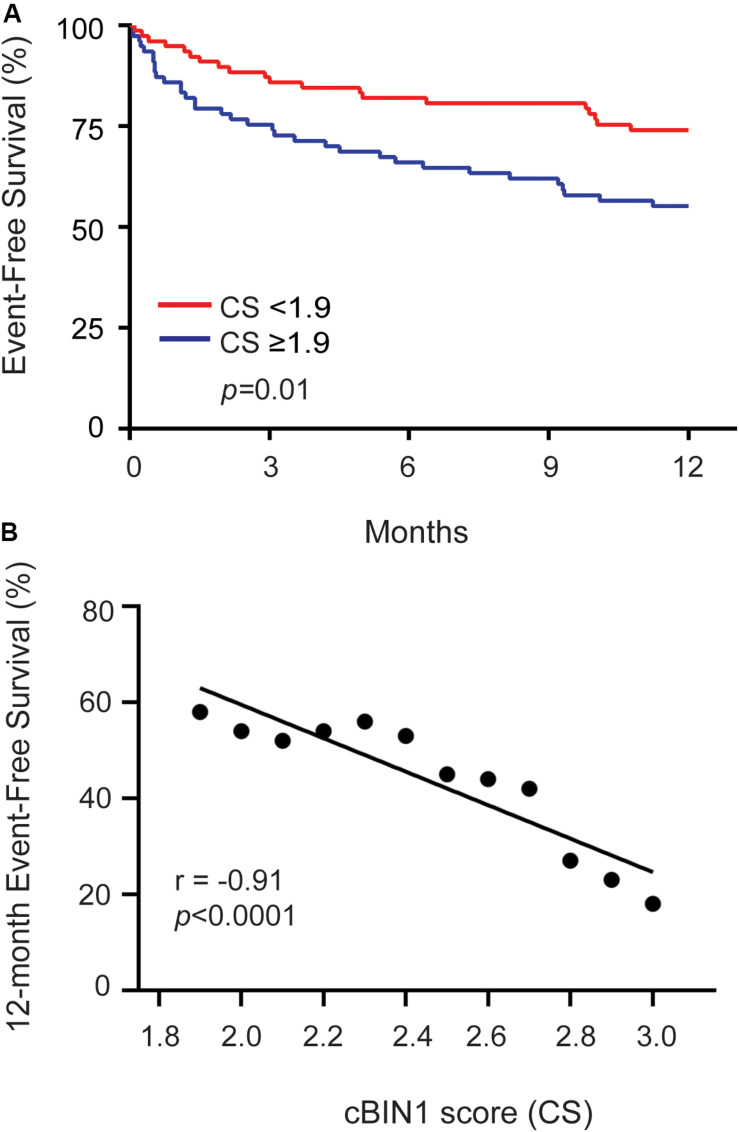
Cardiovascular event free survival of HFrEF patients during 12-month follow-up. (A) Kaplain-Meier survival curve is shown here for all HFrEF patients. The red line demonstrates patients with CS < 1.9 and the blue line demonstrate patients with CS ≥ 1.9. Event free survival is defined as patients who did not have a cardiovascular (CV) event (HF-related hospitalization, cardiac hospitalization, LVAD, OHT, or death) during 12-months follow-up. A low CS (<1.9) predicted a higher event-free survival among all HFrEF patients (p = 0.01). (B) Scatterplot of 12-month event-free survival vs. CS for all CS ≥ 1.9 indicates a negative correlation (Pearsons’s correlation coefficient −0.91, p < 0.0001).